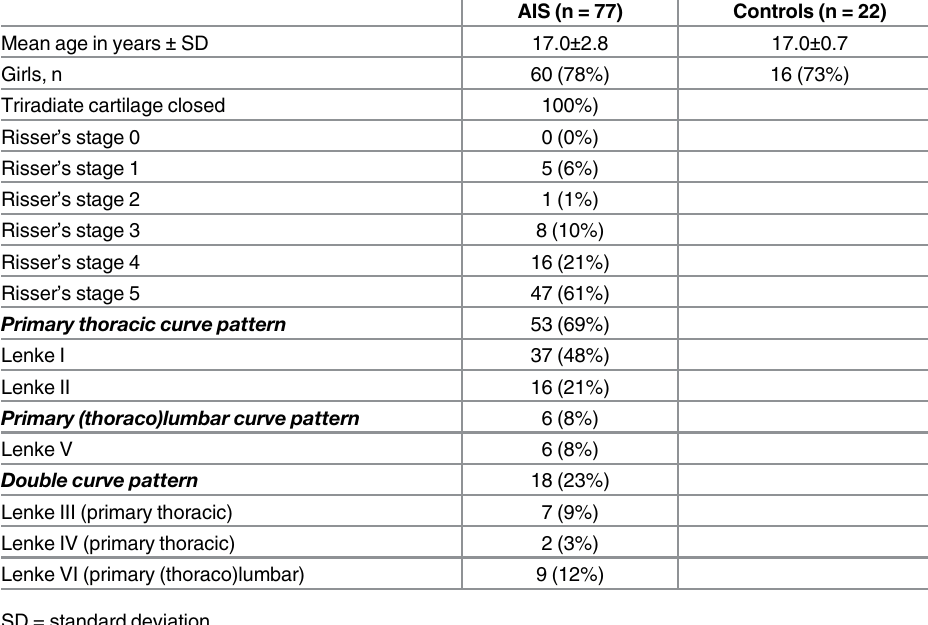
Table 1. Demographic data are shown for the adolescent idiopathic scoliosis (AIS) patients and matched controls.